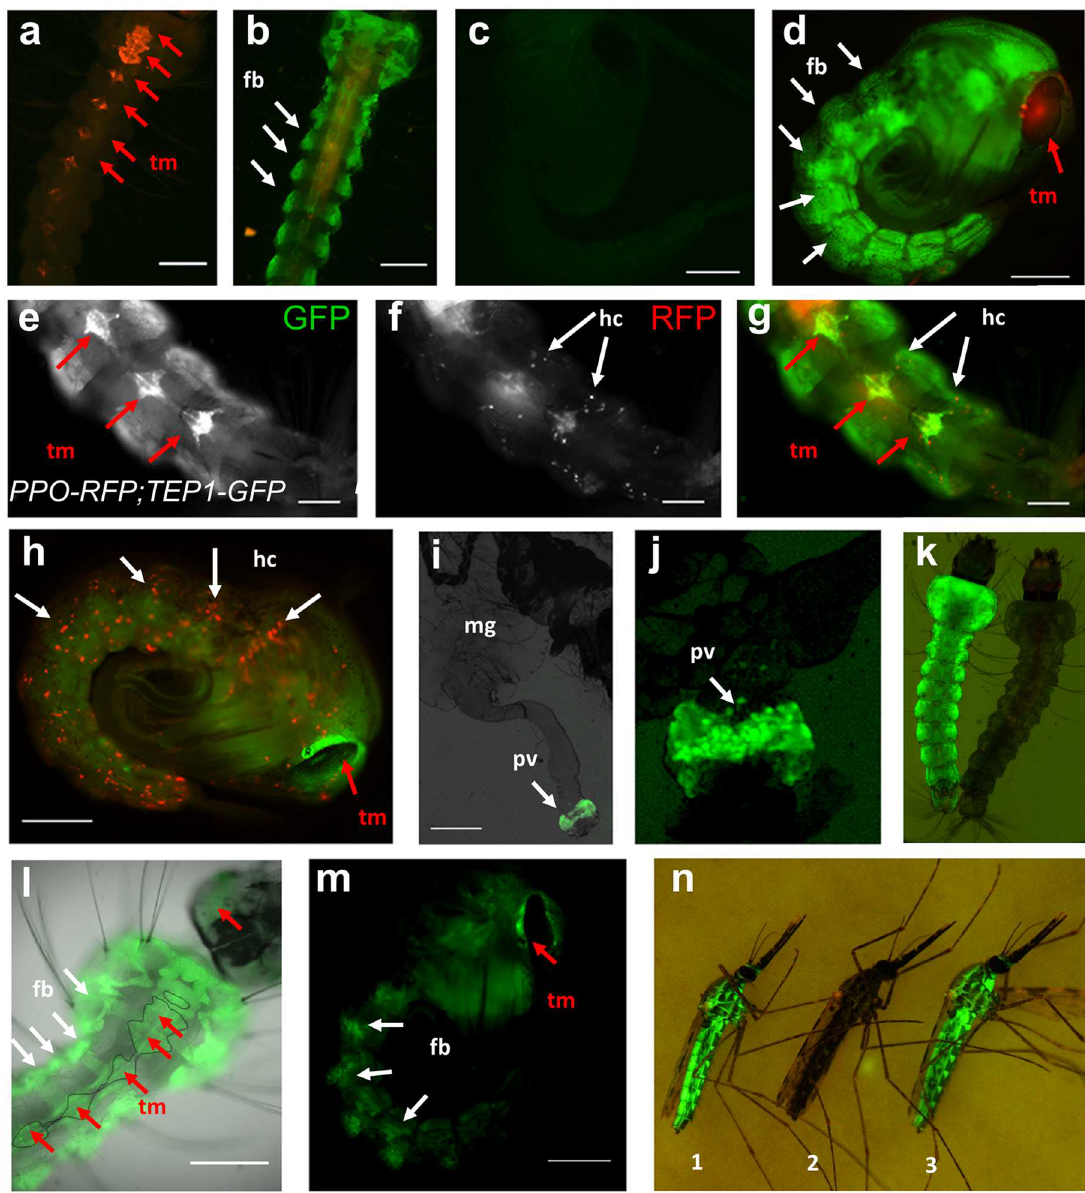
Fig 1. Expression patterns of transgenic reporter lines. The 3xP3 promoter drives expressionof transgenesis markers in eyes and nerve cells. a . Control 3xP3-RFP transgenic A . gambiae larva, image is a merge of green and red channels.Red arrows point to RFP expressionin nerve cells, used as transgenesis marker (tm). b . TEP1-GFP , 3xP3-RFP larva. Arrows point to some of the lobes of the fat body expressingGFP. Note the fine architecture of thoracic fat body revealedby GFP expression. c . control wild type pupa, showinglittle auto fluorescence in the green channel. d . TEP1-GFP , 3xP3-RFP pupa showingGFP expressionin fat body (fb, white arrows) and RFP expressionin the eye (red arrows, tm). e-g. Larva carrying both ppo6-RFP , 3xP3-YFP and TEP1-GFP , 3xP3-RFP . RFP is expressedin hemocytes (white arrows) while GFP is expressedin fat body cells. YFP and RFP transgenicmarkers (red arrows, tm) are expressedin the nervous system. Scale bar = 200 μ m h. RFP and YFP expressionin ppo6-RFP , 3xP3-YFP pupa, showingRFP expressionin hemocytes(hc). White arrows point to some RFP expressinghemocytes. Transgenesis YFP marker is expressedin the eye (red arrow, tm). i . Midgut of TEP1-GFP , 3xP3-RFP female 24h after bloodfeeding, showingdistinct GFP expressionin proventriculus. (pv) j . Close-upon a proventriculus expressingGFP in TEP1-GFP gut. k . LRIM1-GFP , OpIE2-pac larva showingGFP expressionin the fat body, alongside a control (wt) larva. l . Larva expressing APL1C-GFP , 3xP3-CFP showingGFP expressionin the fat body (white arrows) and CFP transgenesis marker expression(red arrows, tm) in the nervoussystem (delineatedwith a thin line) m . APL1C-GFP , 3xP3-CFP pupa expressingGFP in the fat body (white arrows) and CFP transgenesis marker in the eyes (tm, red arrow). n. TEP1-GFP (1) and APL1C-GFP (3) adult females with intensereporter expressionin the fat body, visible through the